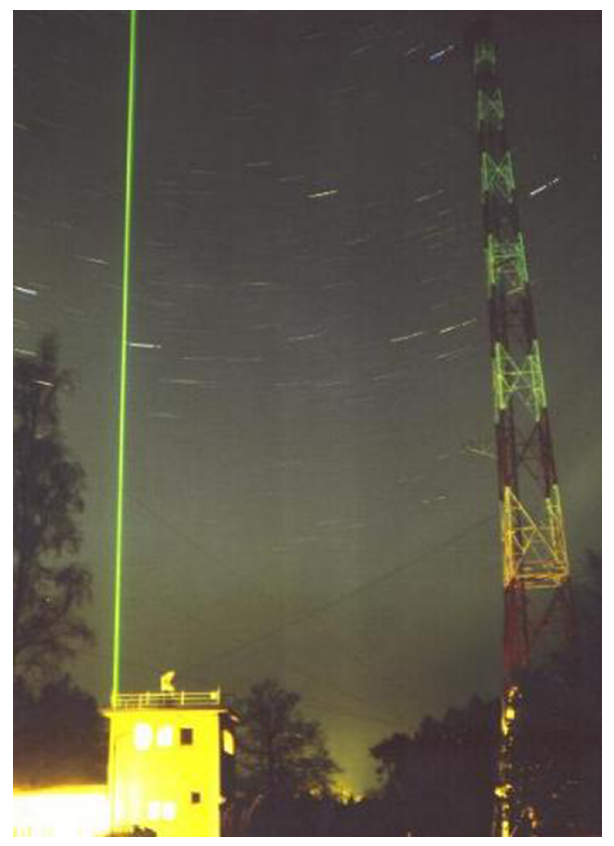
Figure 39. The green beam of